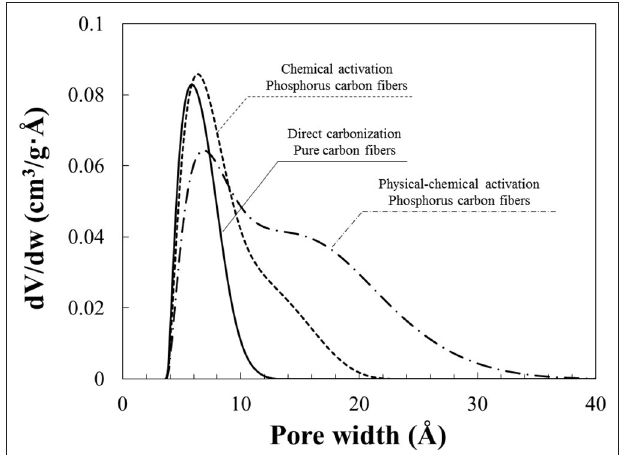
FIGURE 6 | Pore size distribution of carbon fibers prepared by direct carbonization, chemical activation and physical/chemical activation.